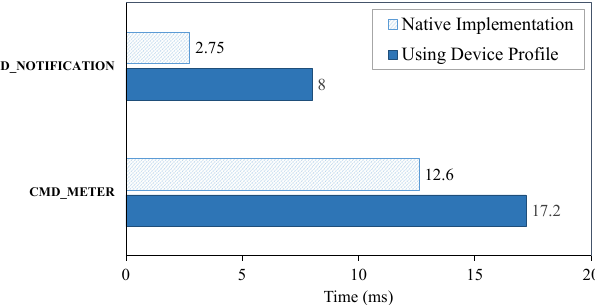
Figure 9. Comparison of the time needed to handle Z-Wave commands in two cases: native implementation and using a device